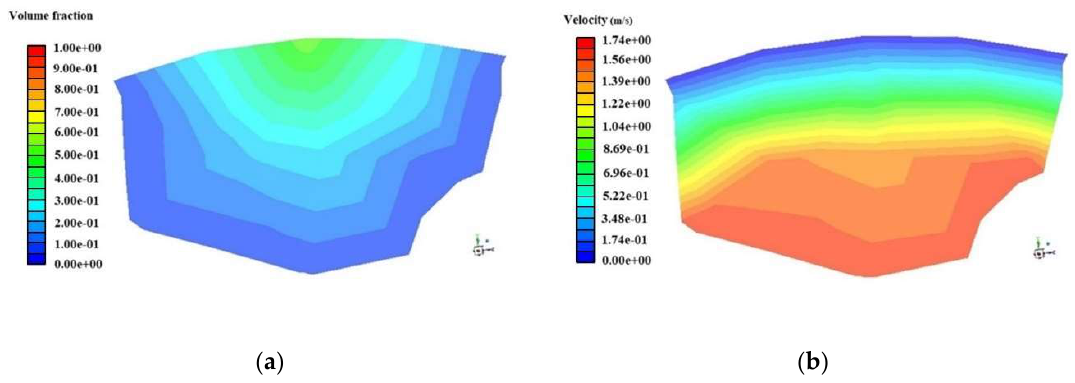
Figure 11. Contours of the distribution of salt solution ( a ) and water velocity ( b ) in the selected region